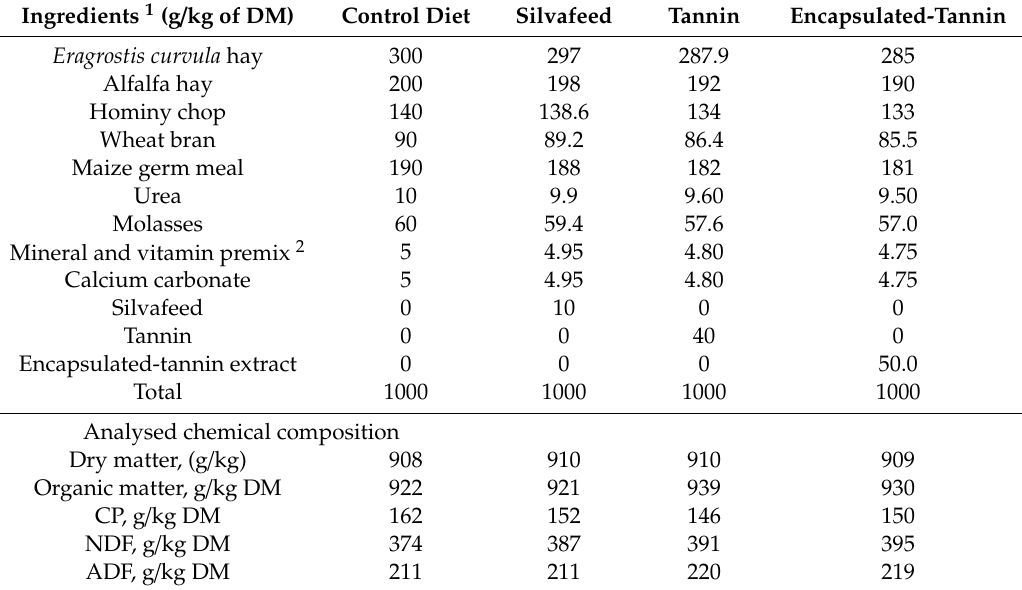
Table 1. Gross composition of ingredient and chemical composition of experimental